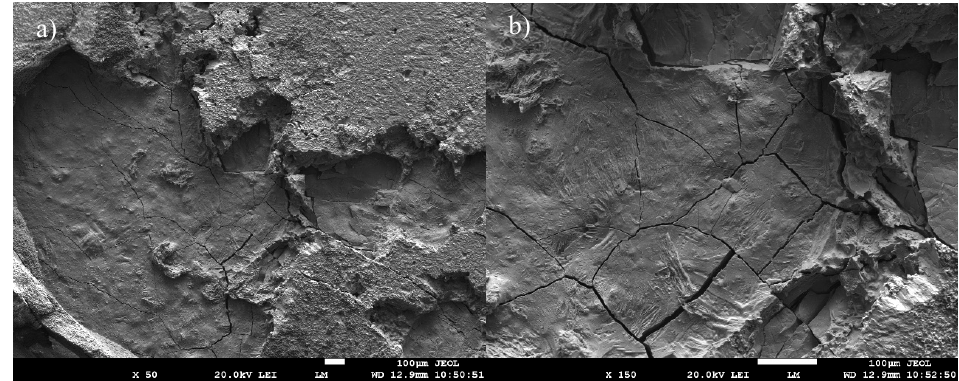
Figure 21. Fractured surface of soldered AlN/Zn5Al3Mg/Cu joint ( a ) magnification 50×, ( b ) magnification 150×.